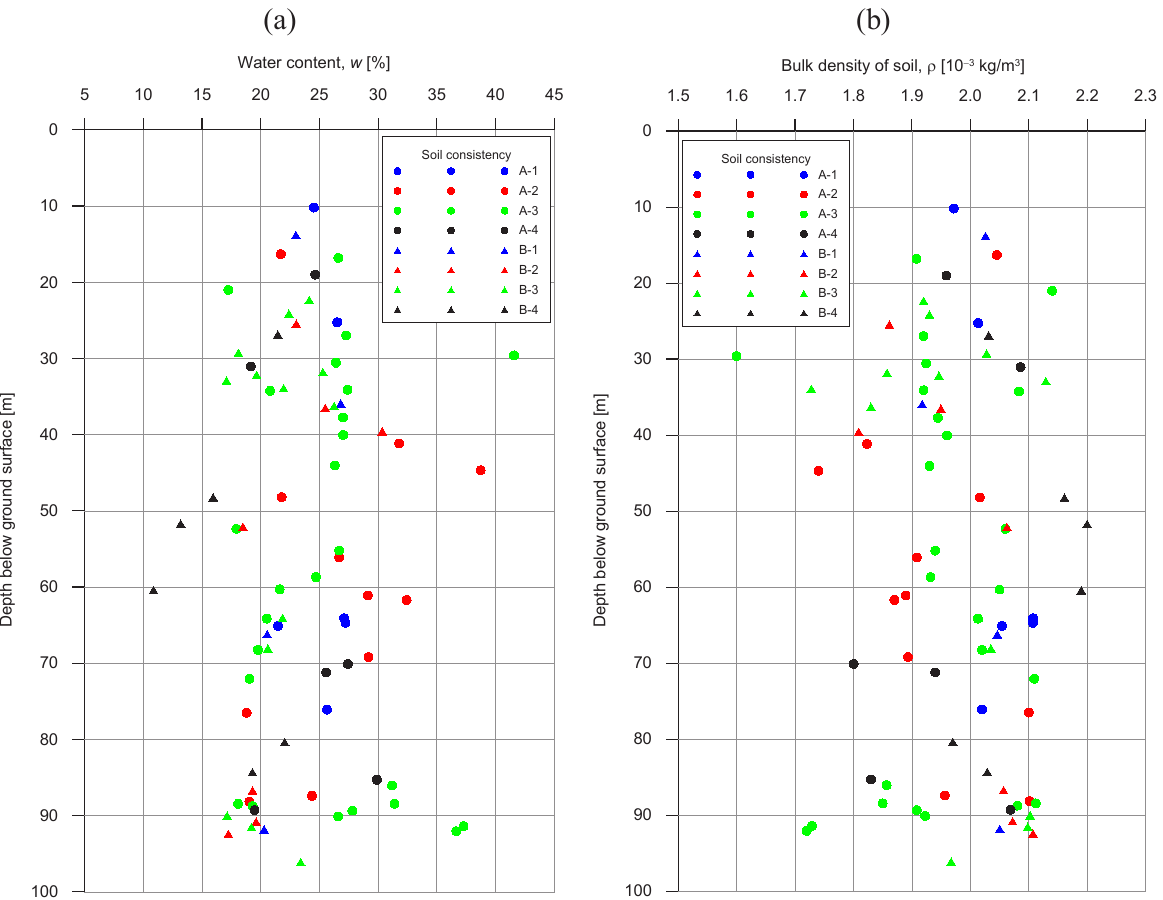
Figure 6: Changes in the average water content, bulk density and consistency of the dump soil for particular sections of the samples.